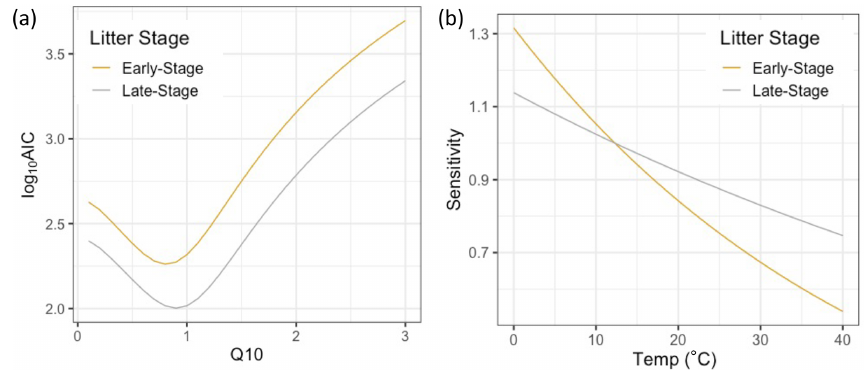
Figure A6. (a) Parameter estimation plot of Q 10 coefficient for an Q 10 -only model run (i.e., with no NRM sensitivity) showing model fit is